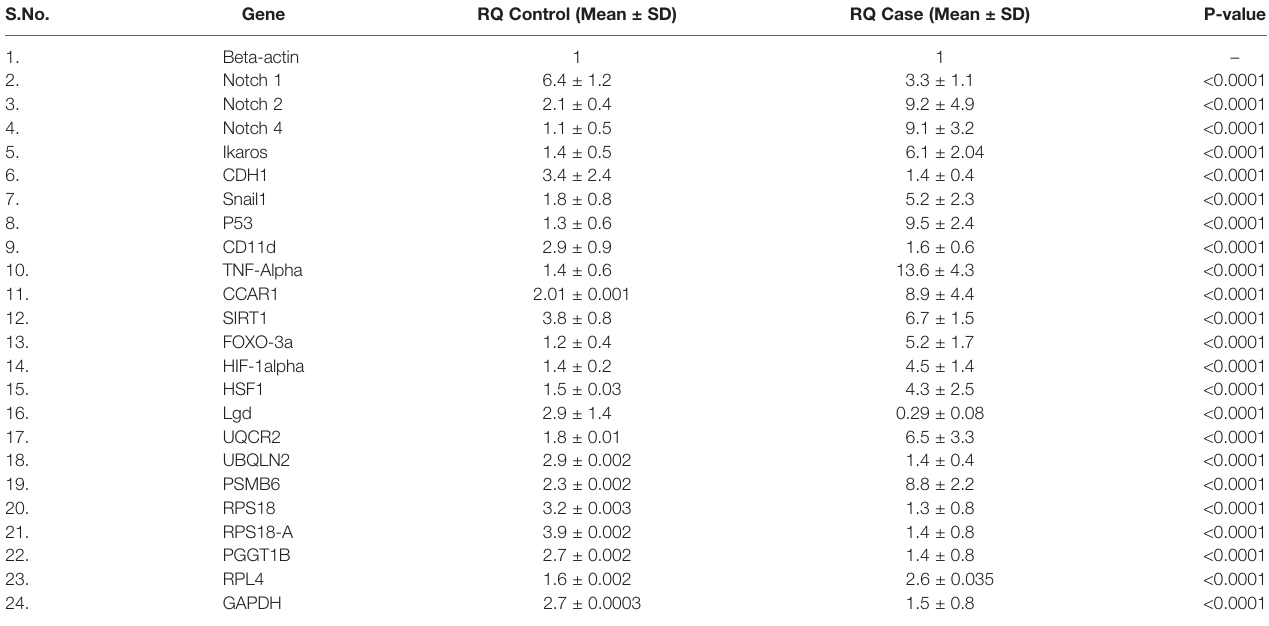
TABLE 4 | Relative expression of genes by